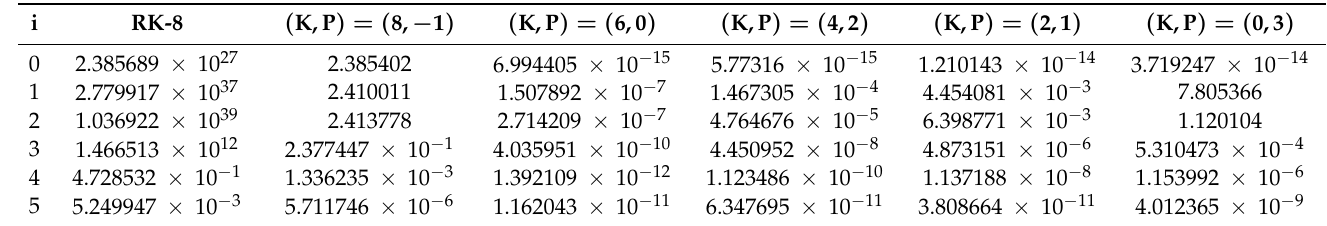
Table 2. Maximum absolute error for constructed methods on Section 5.2 with